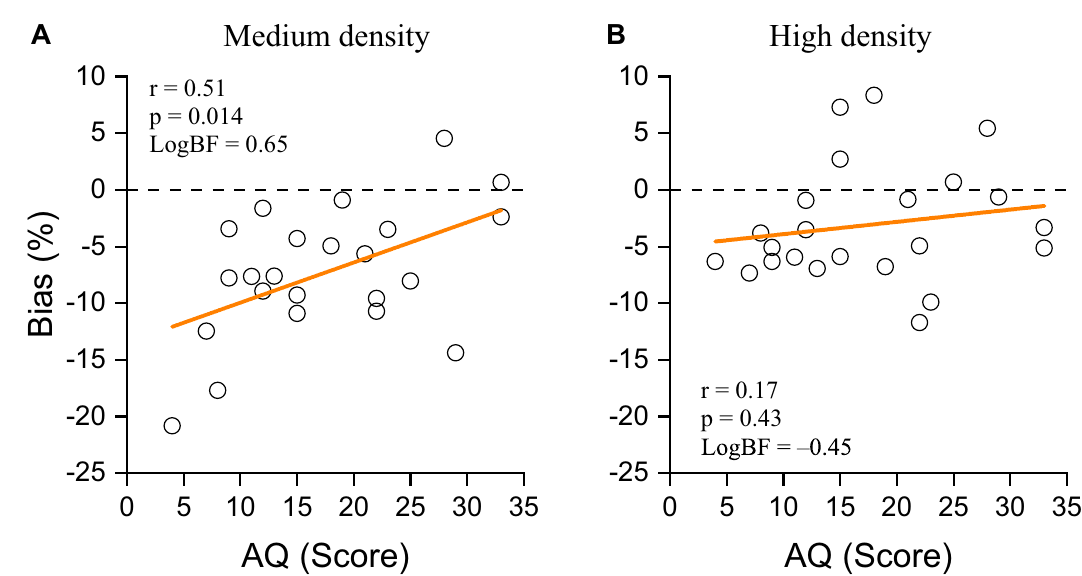
Figure 5. Correlation between Autistic Quotient and Symmetry-induced bias effect. Symmetry bias effect in the estimation range ( A ; medium density) and density regimes ( B ) are plotted against AQ score for all participants. Thick orange lines show the linear functions that best fit the